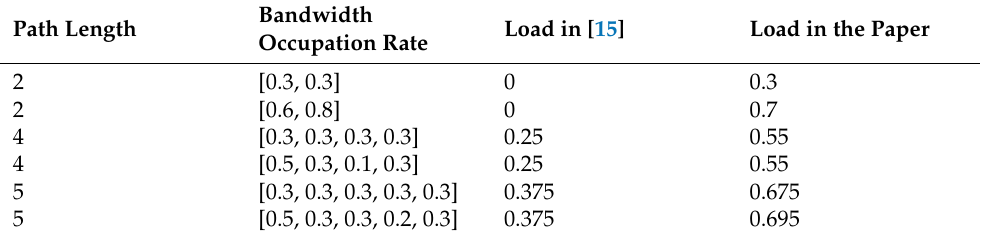
Table 2. Comparison of path load in this paper with that in